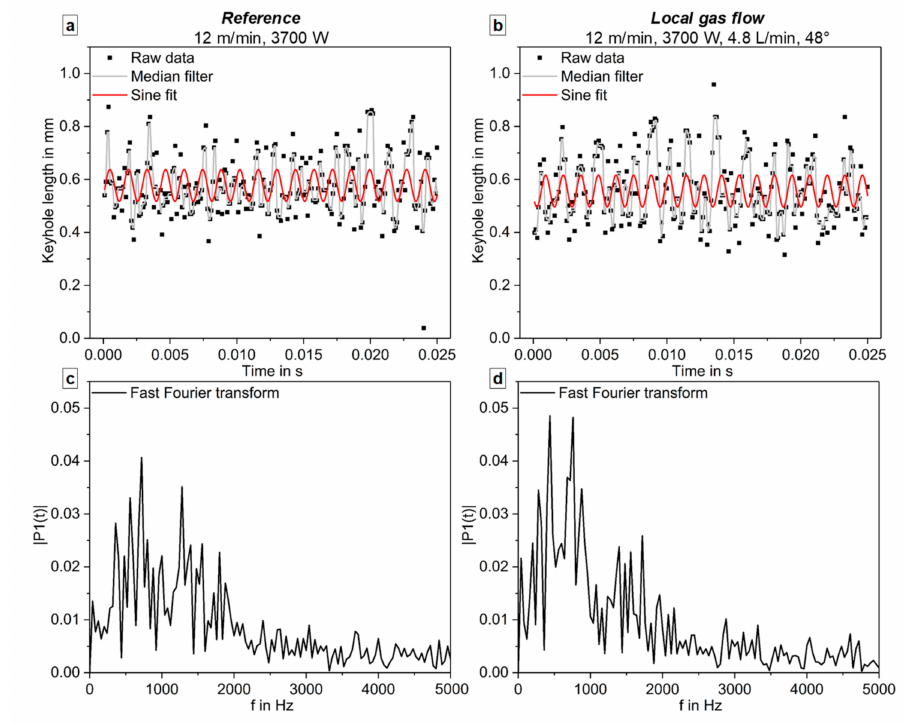
Figure 9. Comparison of reference process and gas-assisted process at a welding speed of 12 m / min regarding: ( a , b ) Keyhole length as function of time; ( c , d ) Frequency spectrum of keyhole oscillation.